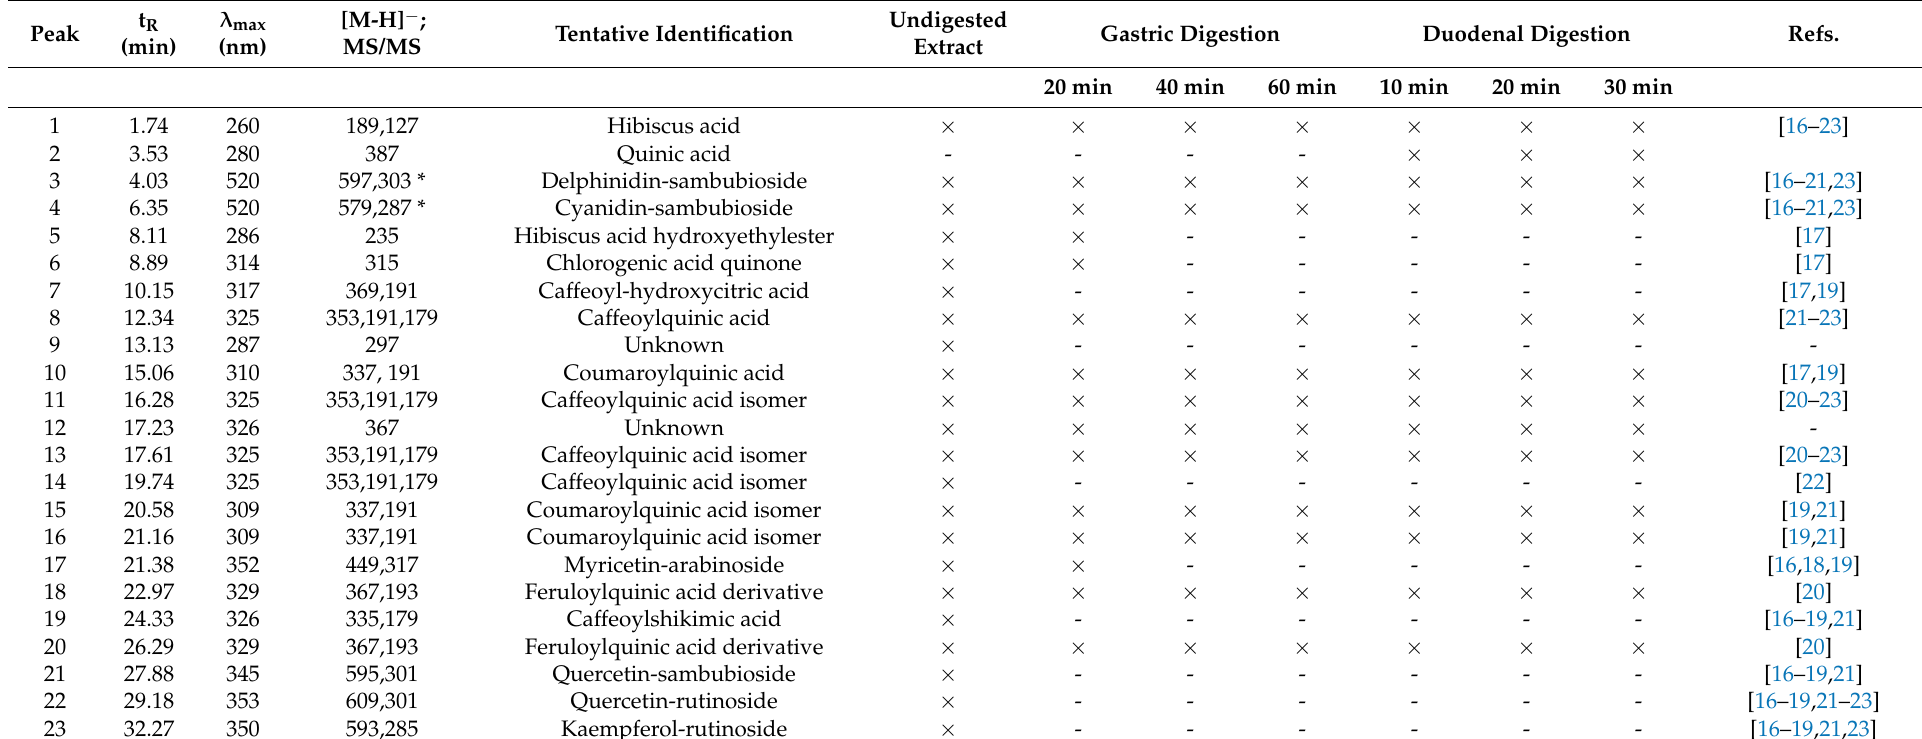
Table 1. Identification of the available polyphenolic compounds in the extract of H.s. during simulated human digestion. x indicates the presence of the compound in the H.s . extract.—indicates absence of the compound in the